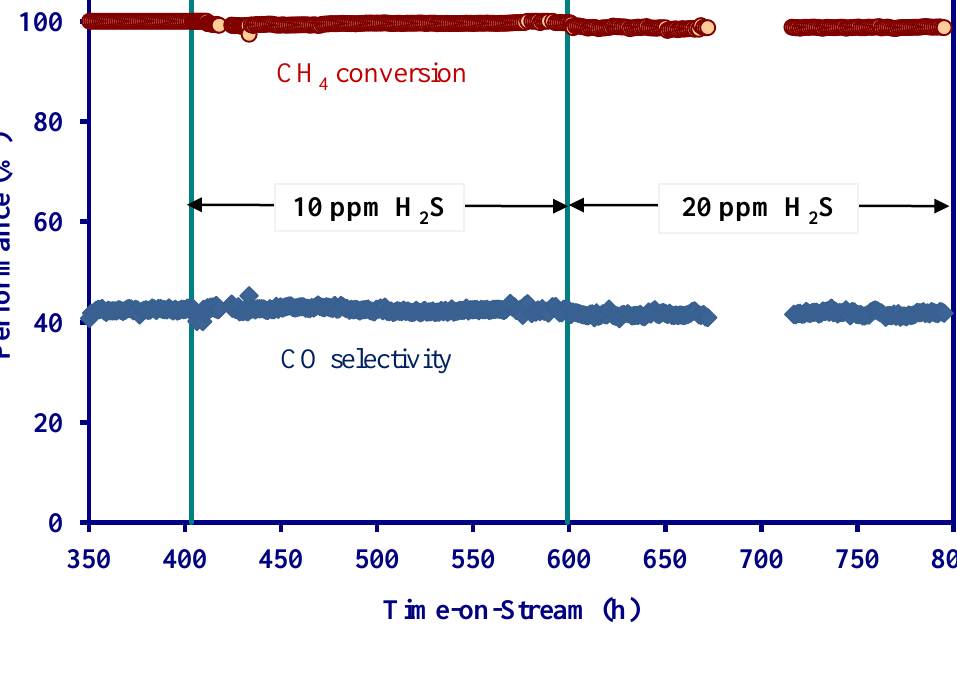
, 7.8% CH , 43.3% N , 23.0% H O, 10 and 20 ppm 2 4 2 2